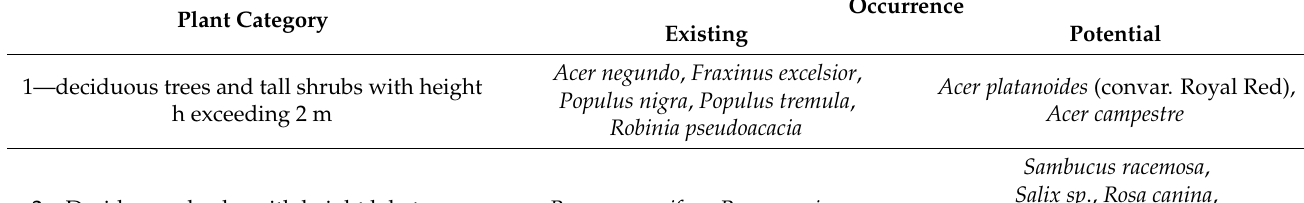
Table 4. Plant categories and species which may be used in landfill